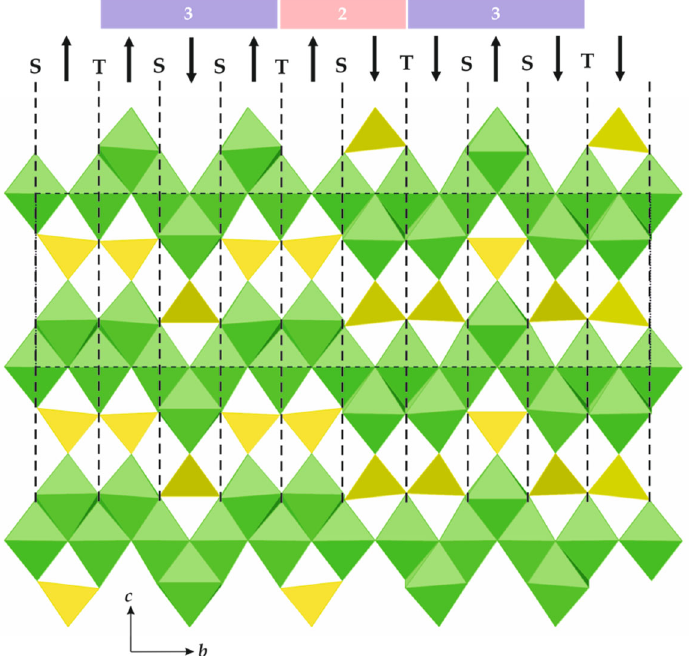
Figure 8. The crystal structure of spinel projected along [110] ( a ) and the ball ‐ and ‐ stick representa ‐ tion of a spinel module ( b ). The dashed lines outline the contours of the modules, whereas the ar ‐ rows indicate their orientation. The T ‐ and M ‐ centered polyhedra in ( a ) are shown in yellow and green, respectively.